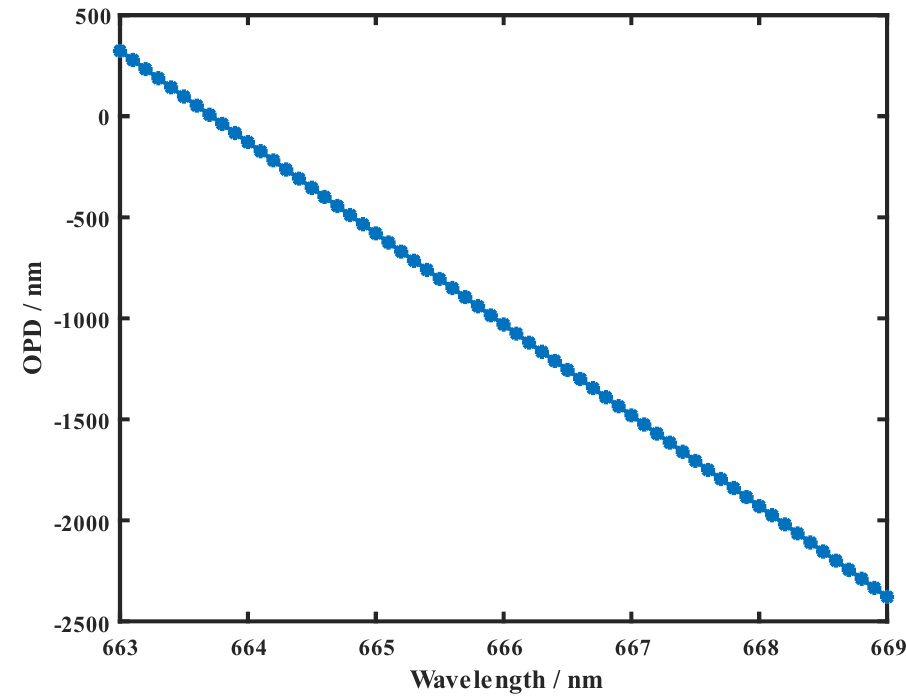
Figure 2. OPD in difference wavelength after correction (150 µ m).